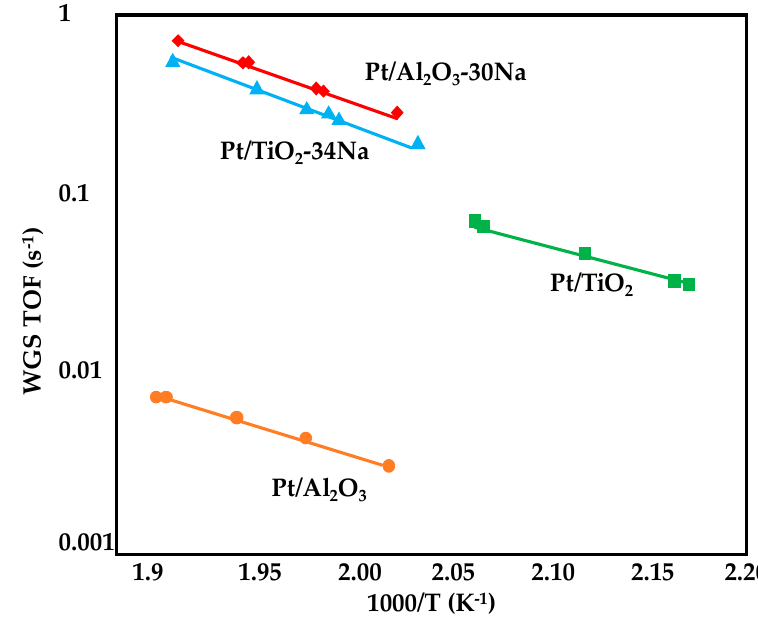
Figure 16. Arrhenius plot for the promoted and un-promoted Pt / Al 2 O 3 and Pt / TiO 2 catalysts, reproduced or adapted from [98], with permission from Elsevier, 2012; P = 1 atm, 6.8% CO, 8.5% CO 2 , 21.9% H 2 O, 37.4% H 2 , 24.4% Ar.